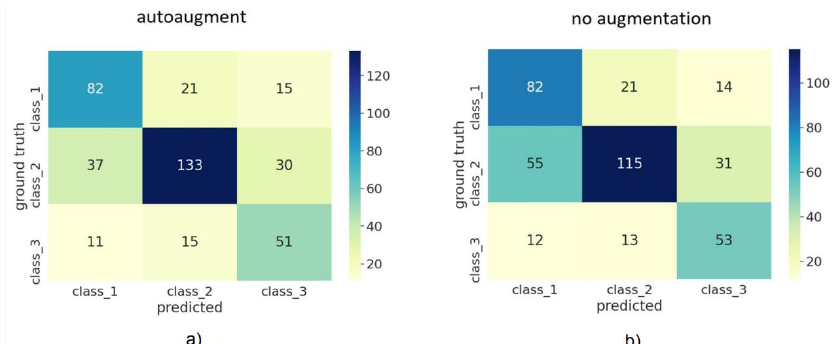
Figure 5. Average confusion matrix for cross-validation using automatic Image Augmentation in ( a ) and without augmentation in ( b ). It can be observed that using automated augmentation reduced the number of misclassifications for class 2 and increased the number of correctly classified images for this class. Confidence intervals were omitted for readability.